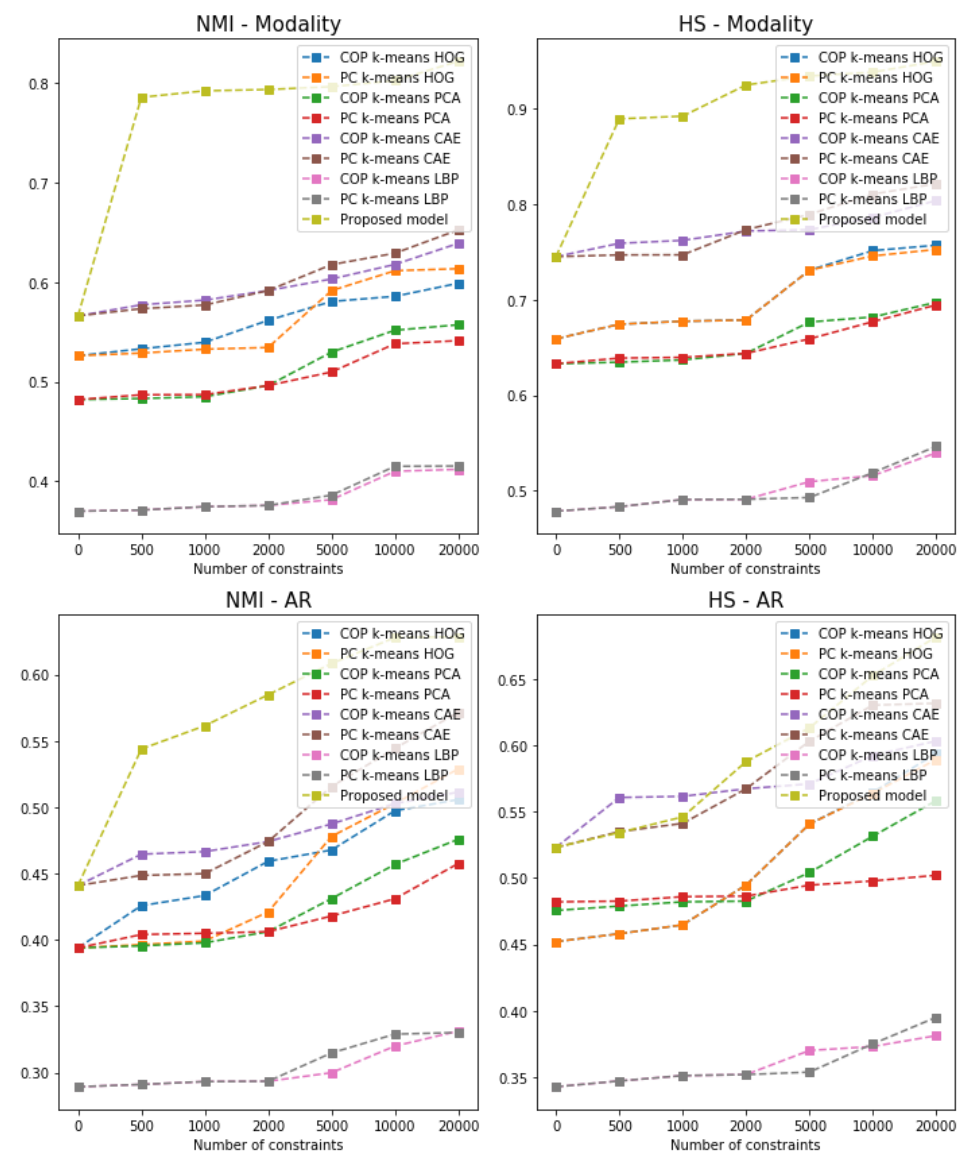
Figure 6. Clustering results on the train and test subsets with respect to the percentage of labelled instances used and the number of constraints